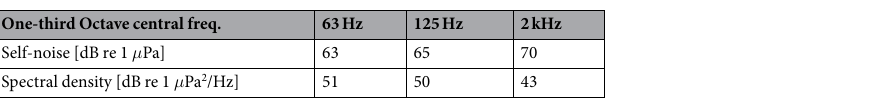
Table 2. Evaluated self-noise and spectral densities of the SM2M recorder in the one-third octave bands 63 Hz, 125 Hz and 2